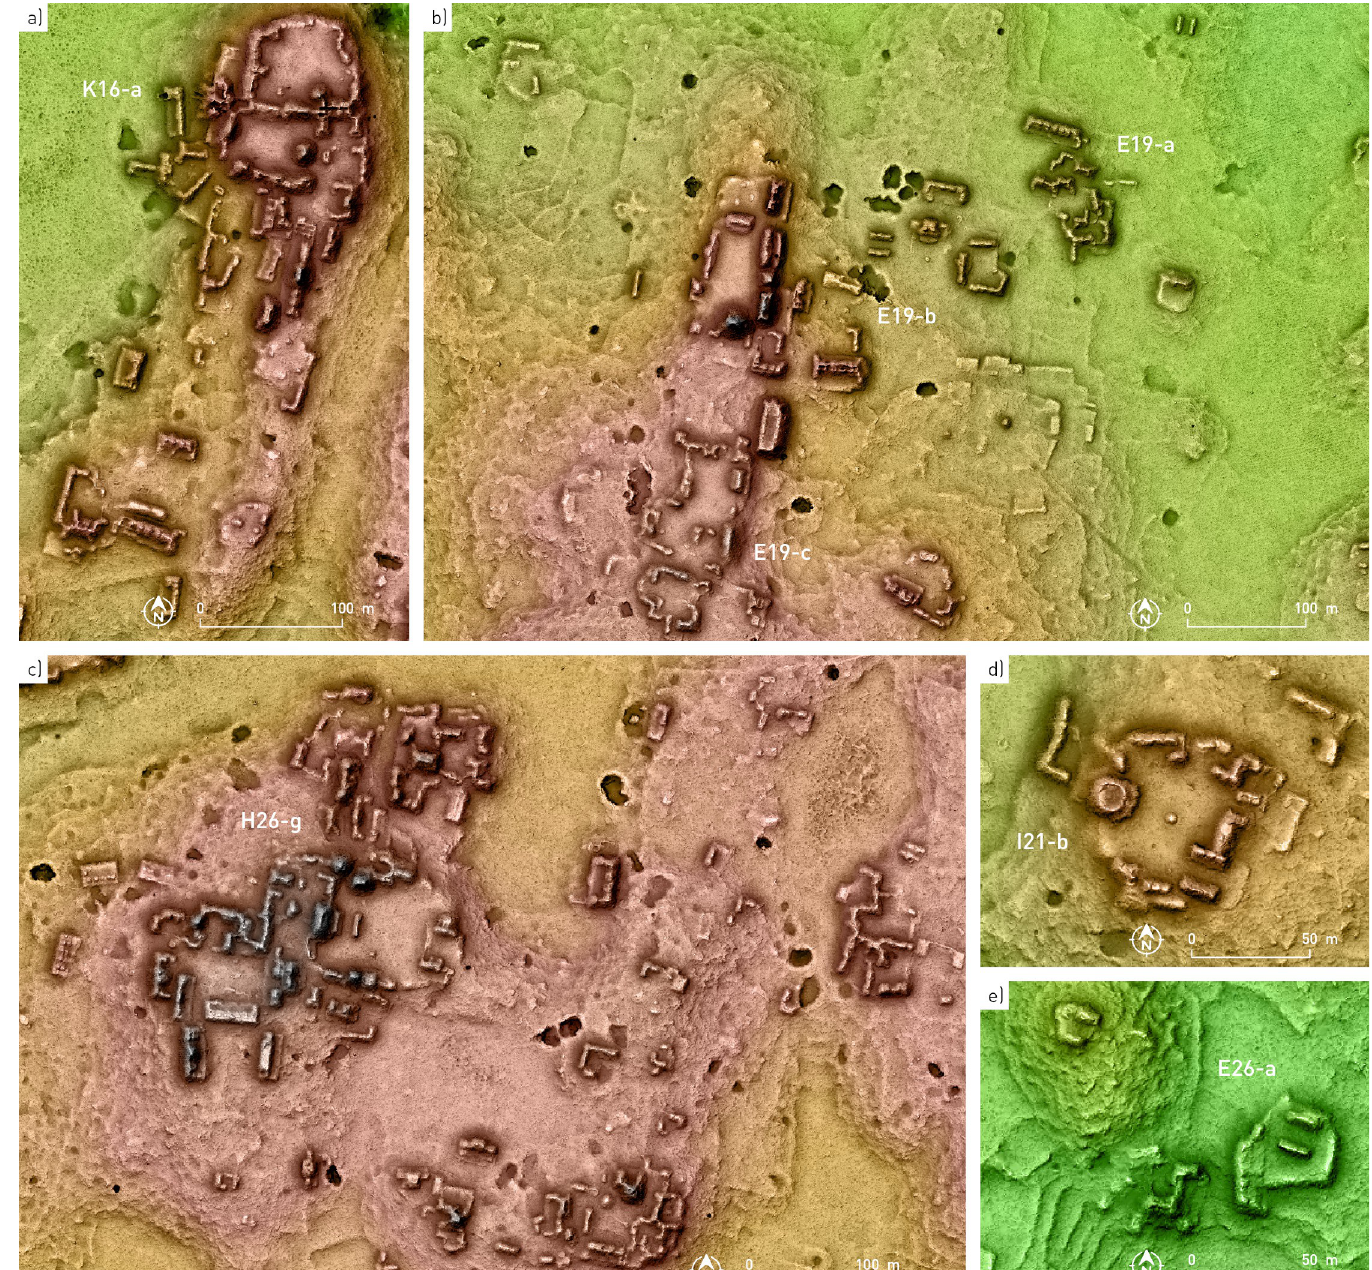
Fig 5. Examples of settlement